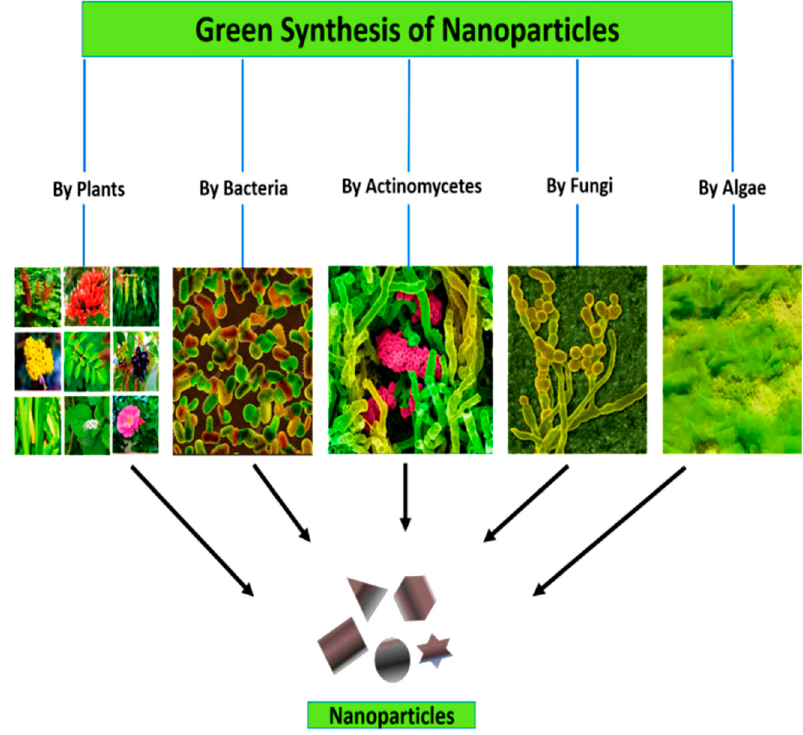
Figure 4. Green synthesis of NPs.